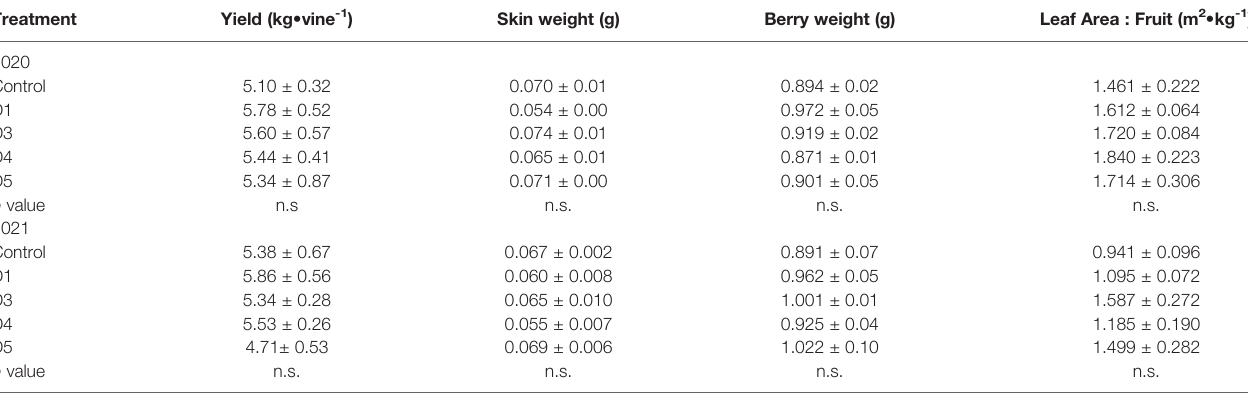
TABLE 3 | Effects of photo-selective overhead shade fi lms on yield components of ‘ Cabernet Sauvignon/110R ’ in Oakville, CA, USA ab . Treatment